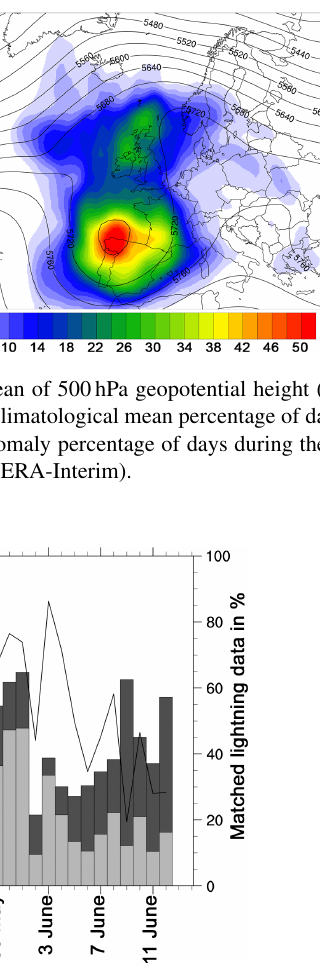
Figure 11. Lightning strikes per day (03:00–03:00UTC on the next day) during the study period for all thunderstorm events (dark grey bars) and those thunderstorms that can be linked to a cut-off low (light grey bars). The black line shows the percentage of lightning strikes per day that can be attributed to a cut-off low.